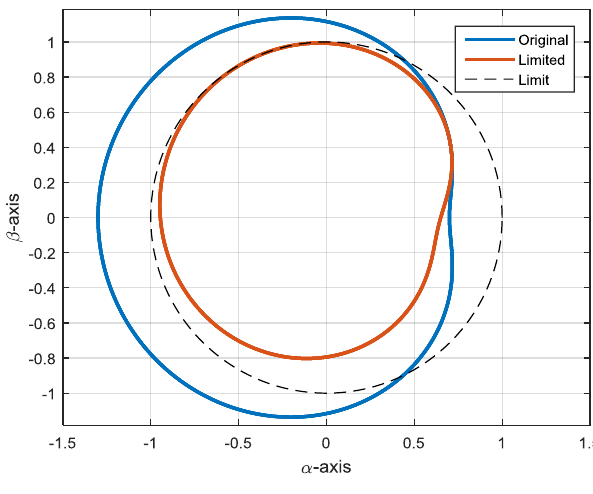
Figure 19. SRF saturator operation.